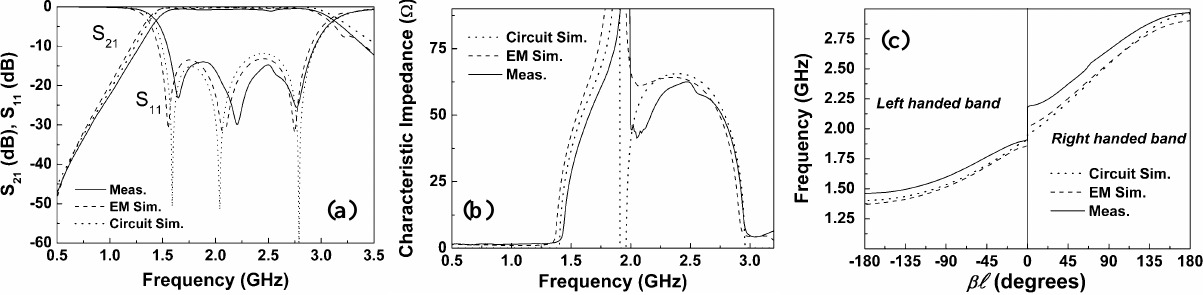
Figure 17. ( a ) Frequency response of the circuit of Figure 16. ( b ) Characteristic impedance. ( c ) Dispersion diagram. The element values of the circuit model are (in reference of Figure 13(c) and Figure 14(c)): L’ = 6.94 nH, C = 0.85 pF, C = 0.28 pF, L = 0.76 nH, s s L’ = 1.95 nH and C’ = 2.43 pF. From [43]; copyright  2009, IEEE; reprinted with p p